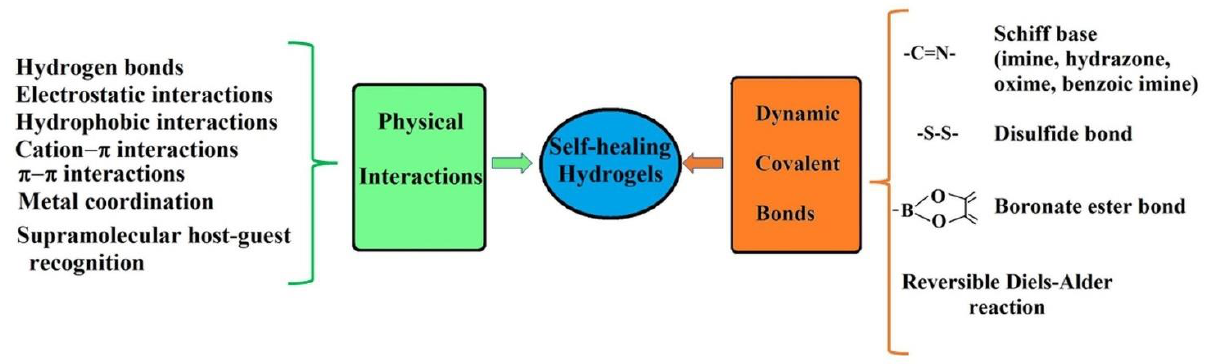
Figure 1. Physical and covalent bonds that provide the gels with self-healing ability.